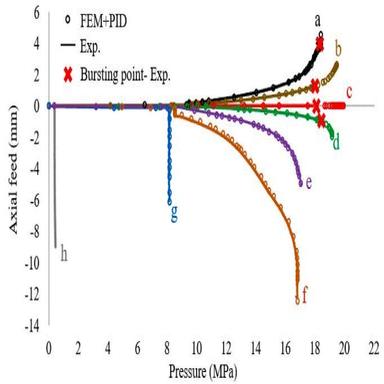
FEM + PID boundary conditions accurately followed by the THF machine for the eight different deformation paths, a-h.